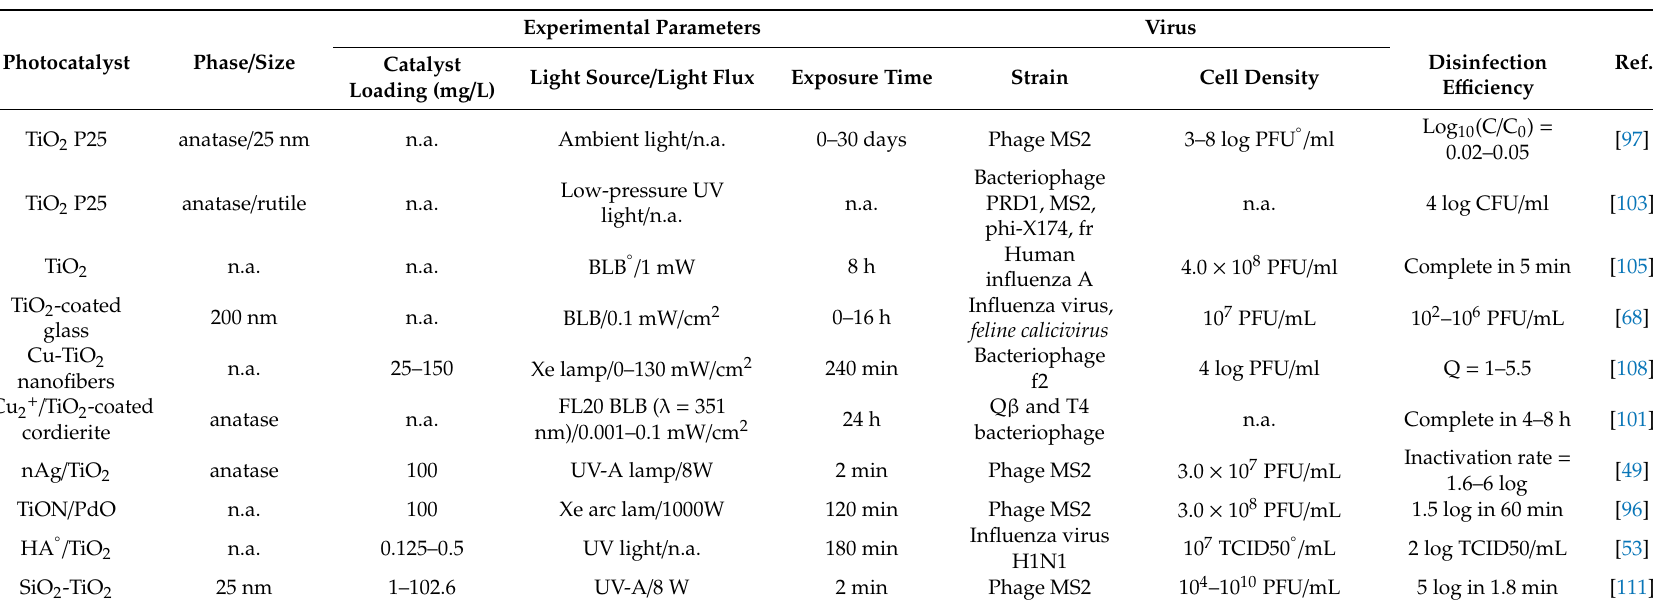
Table 2. Summary of the experimental conditions reported in the literature for TiO 2 and TiO 2 -based nanocomposite photocatalyzed viral disinfection.